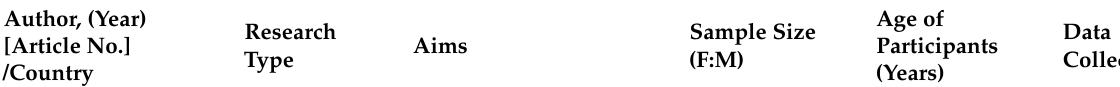
Table 2. Summary of the included